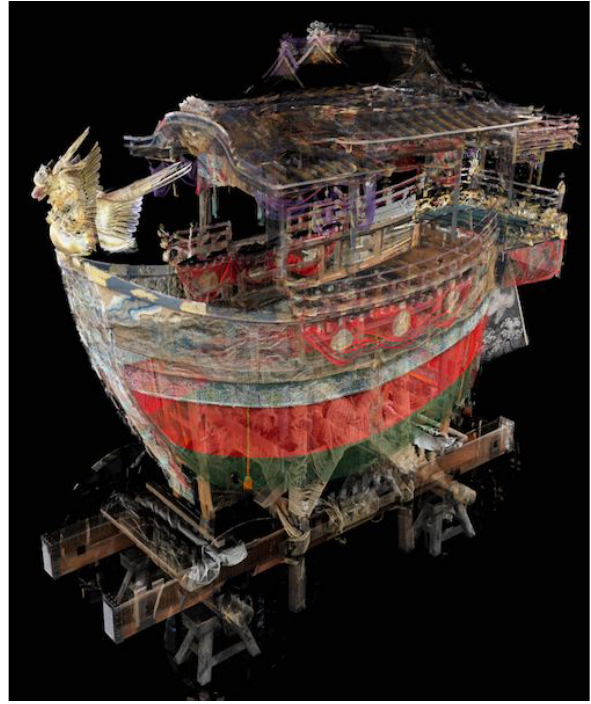
Figure 2. See-through imaging of a laser-scanned point cloud of the Fune-Hoko float used in the Gion